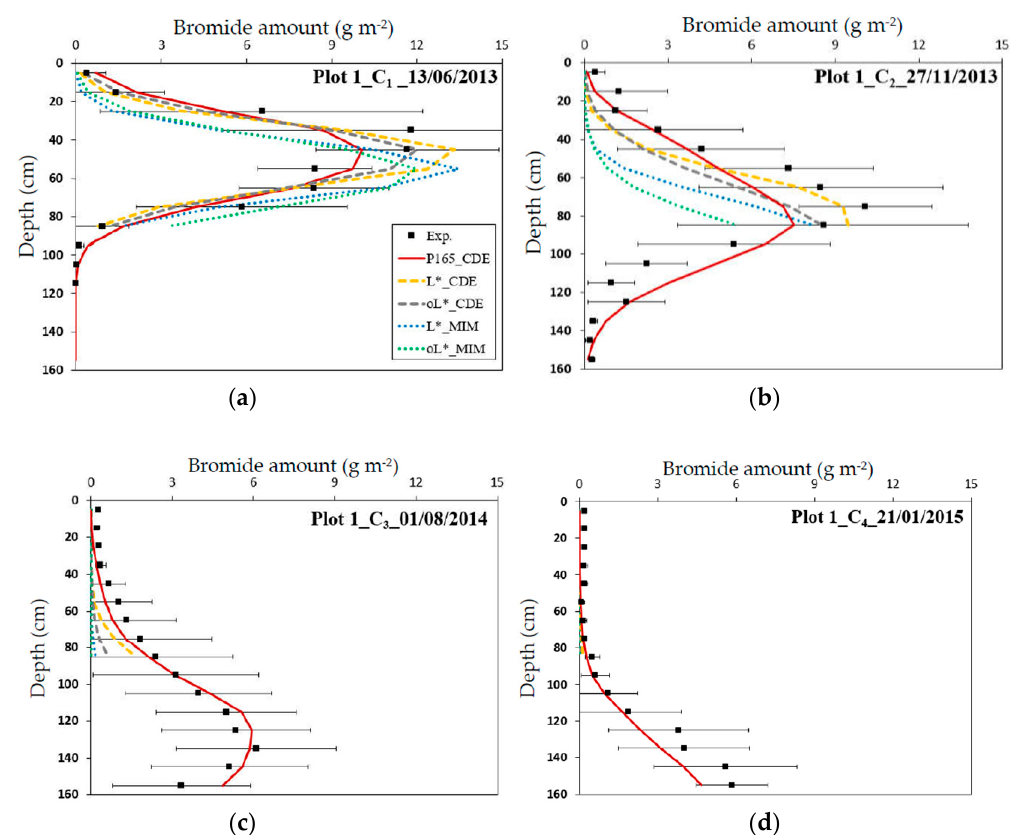
Figure 5. Comparison between experimental and simulated bromide concentrations in Field Plot 1 for the four monitoring campaigns (C 1 ( a ), C 2 ( b ), C 3 ( c ), and C 4 ( d )). Each experimental point is the average of 8 to 11 samples and is accompanied by its standard deviation. P165_CDE for results obtained with HYDRUS-1D with the convection-dispersion equation and parameters optimized on the 165 cm deep profile; L*_CDE for the results obtained with the convection-dispersion equation and by applying the mean optimized parameters from the six lysimeters; L*_MIM for the results obtained with the mobile-immobile model and by applying the mean optimized parameters from the six lysimeters; oL*, the same as L* but for saturated water content values ( θ s * ) optimized again for each soil material. Results obtained with the convection-dispersion equation and parameters optimized on the 90 cm deep profile are not shown since no significant differences were found with P165_CDE for simulated bromide amount. Table 4. E ffi ciency coe ffi cients calculated for bromide transport for each monitoring campaign (C 1 to Table 2. Parameters optimized using HYDRUS-1D for each of the eight soil materials of Field Plot 1. C 4 ) conducted on Field Plot 1 and based on di ff erent optimization procedures using HYDRUS-1D. Soil Material Simulation